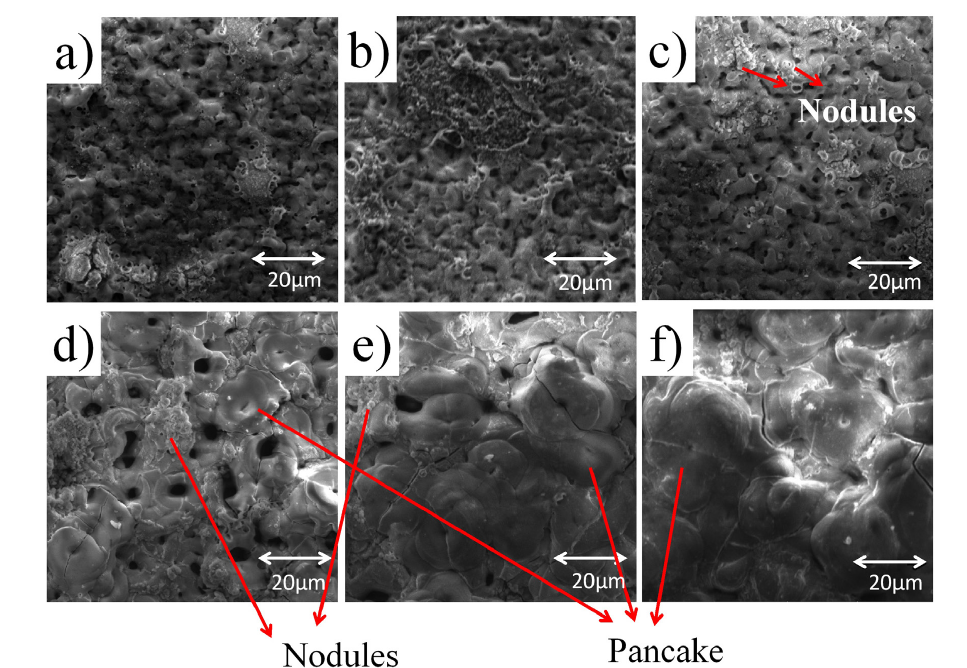
Figure 5. Surface morphology of the PEO treated samples. (a) 50_2; (b) 100_2 ; (c) 150_2; (d) 50_12 (e) 100_12; (f)